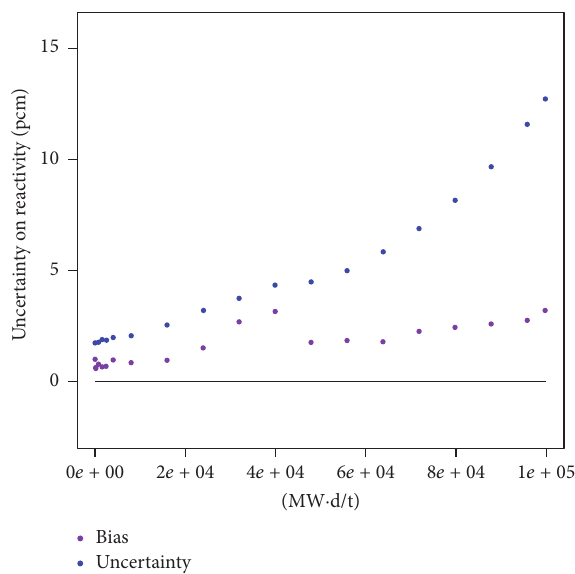
Figure 5: Uncertainty on reactivity (pcm) induced by UO2MB.